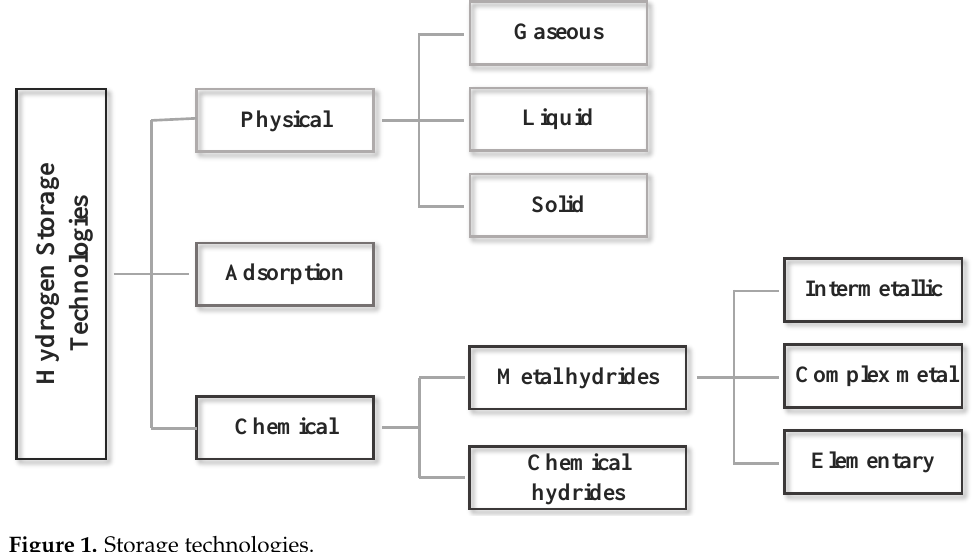
Figure 1. Storage